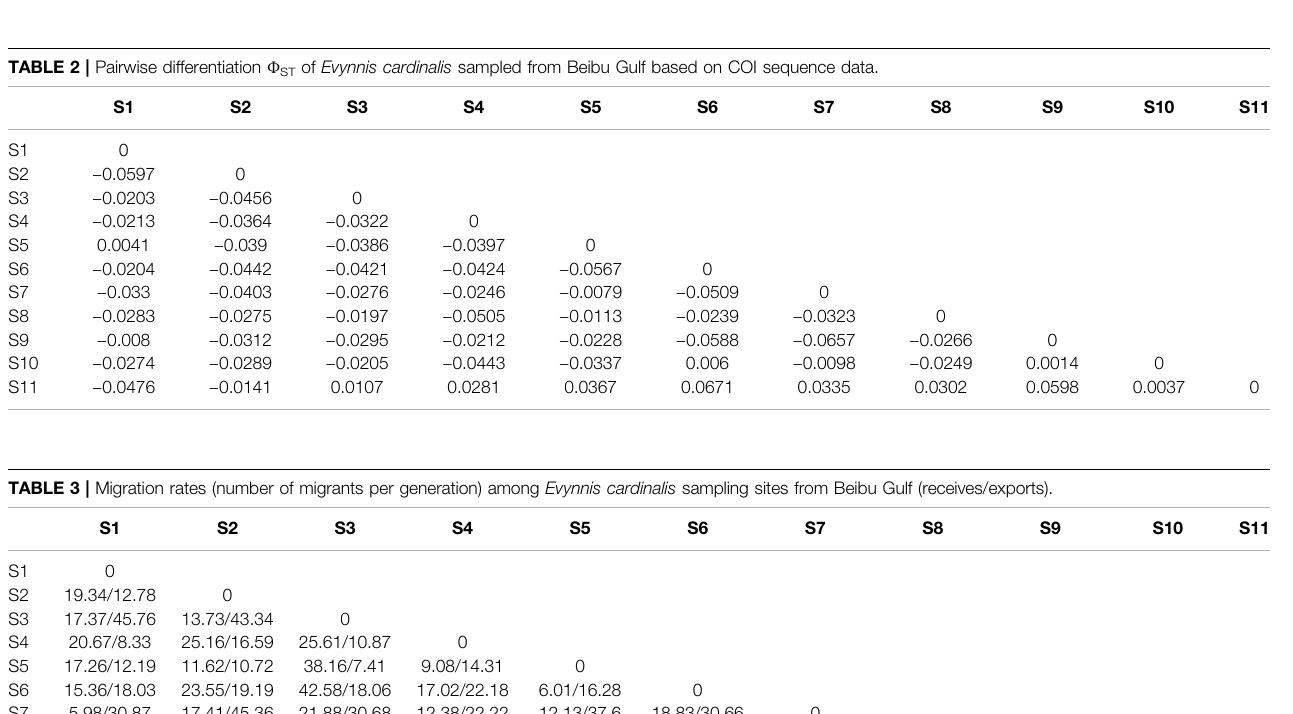
FIGURE3| Piediagramsshowingtherelativeabundanceofdifferenthaplotypesattheelevensamplingsites(totalnumberofdifferenthaplotypes (cid:2) 44).Thesizeof each pie fraction is proportional to the proportion of individuals with a given haplotype.